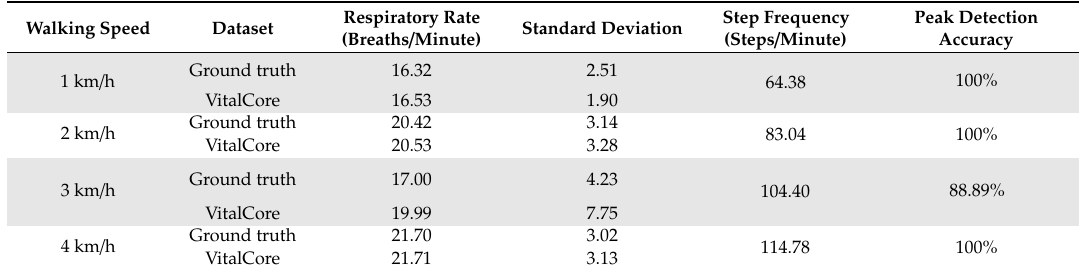
Table 10. Mean respiratory rate, standard deviation comparison for VitalCore with walking step frequency, and respiratory peak